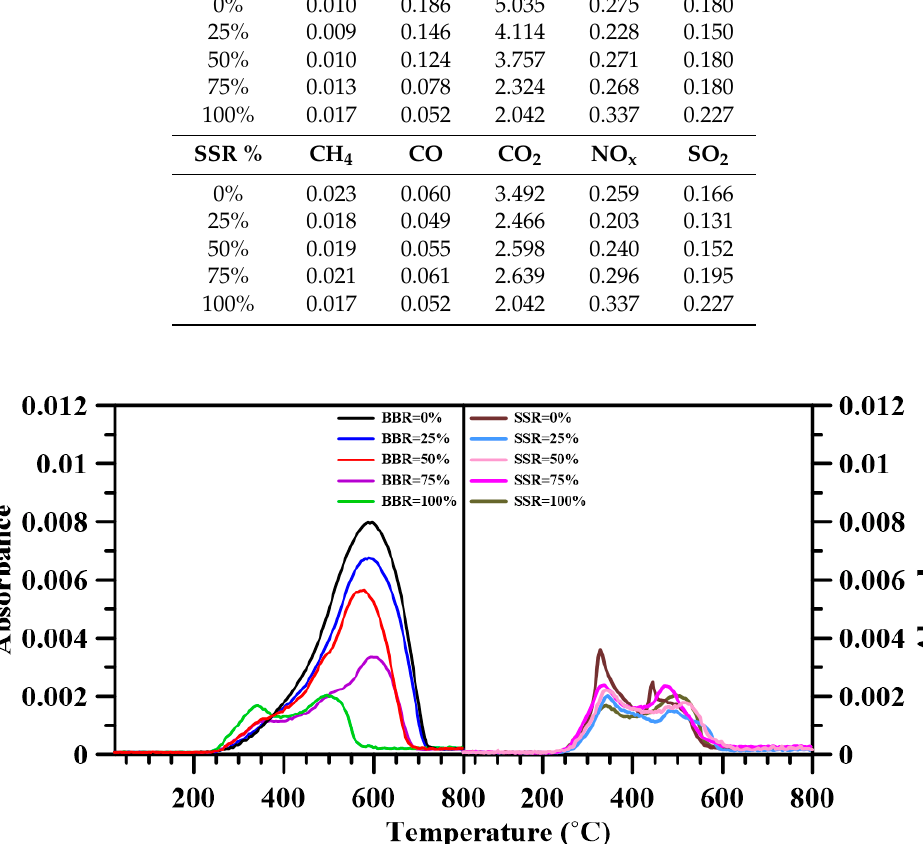
Figure 11. Evolution of CO for various sludge-coal and sludge-shiitake ratios in TGA-FTIR.